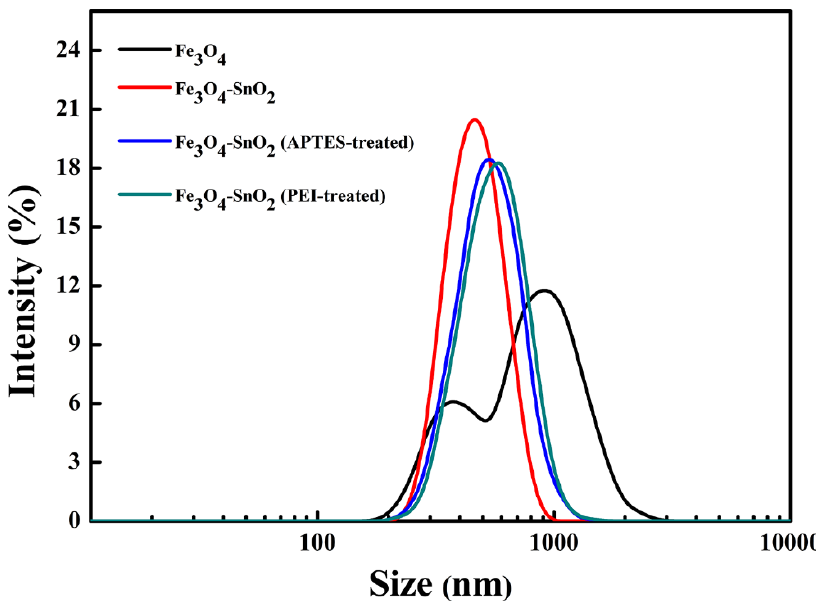
Figure 3. Particle size distribution curves of the as-prepared Fe 3 O 4 , Fe 3 O 4 -SnO 2 , APTES-treated Fe 3 O 4 -SnO 2 , and PEI-treated Fe 3 O 4 -SnO 2 nanoparticles.